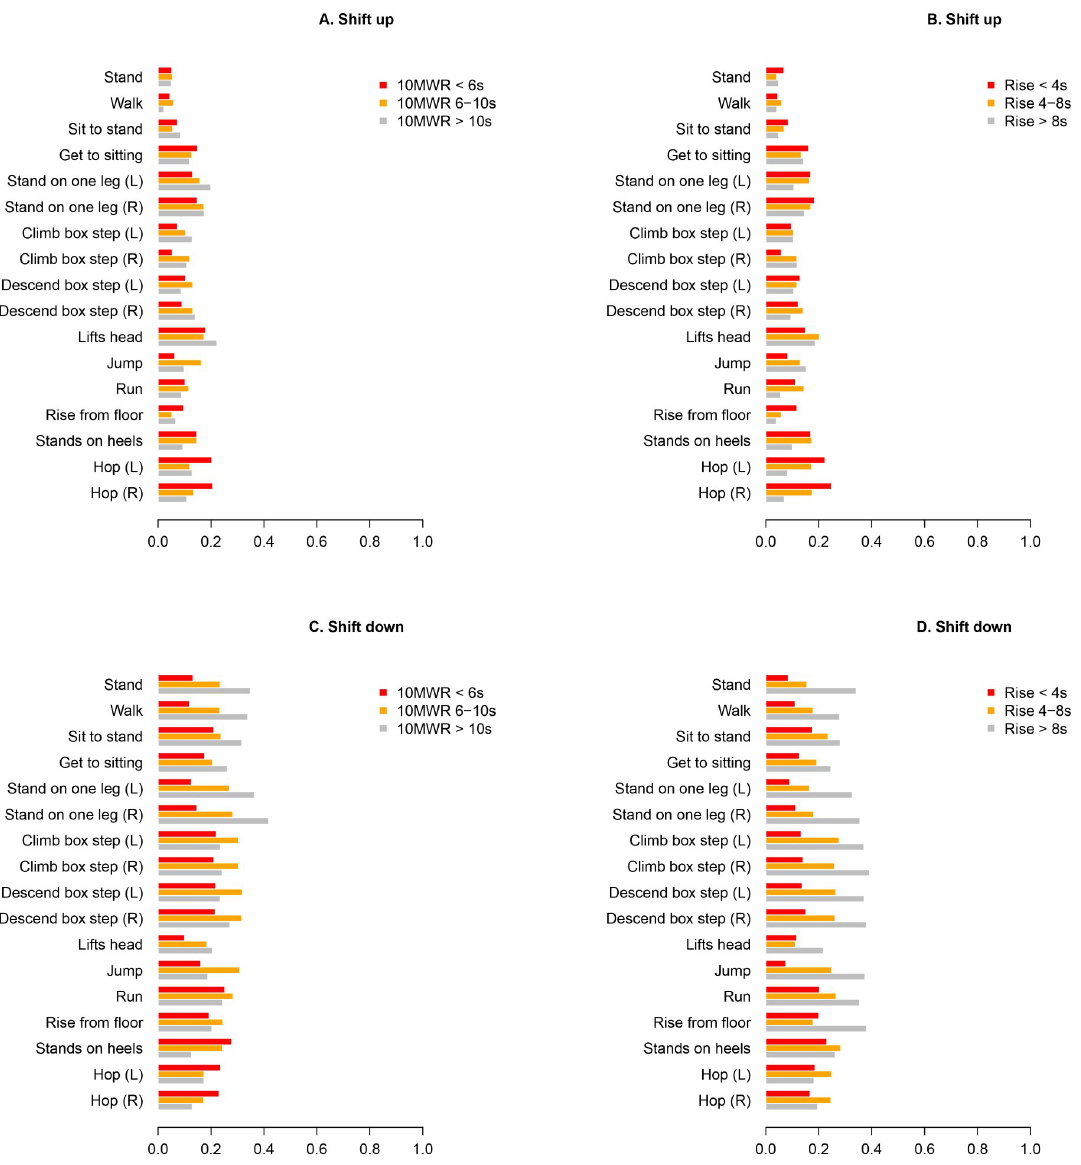
Fig 6. Shifts in NSAA item scores over 1 year: stratification by functional status. Annualised probabilities of shift up in NSAA item scores when stratified by (A) 10 metre walk/run and (B) rise from supine; probability of shift down in (C) 10 metre walk/run and (D) rise from supine. 10MWR, 10 metre walk/run; s, seconds; DMD, Duchenne muscular dystrophy; L, left; NSAA, North Star Ambulatory Assessment; R, right.